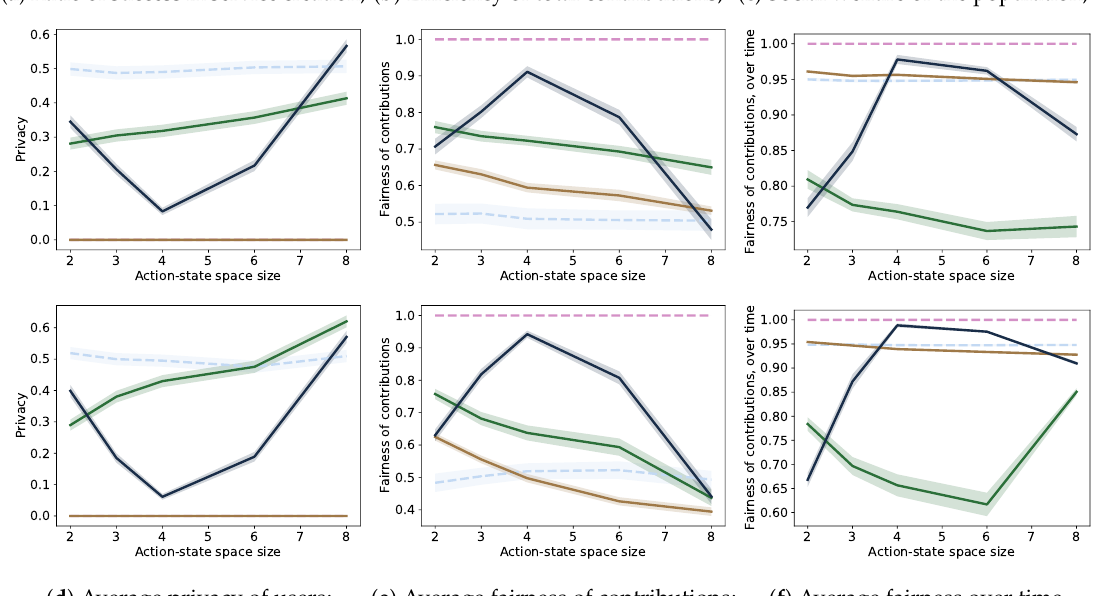
Figure A2. Dependence of results on the range of values and costs ( x -axis). Dashed lines represent baselines, solid lines represent contribution strategies. The plots show a trend for which all contribution strategies tend to perform worse for larger action-state spaces. Q-Learning is the measure that is most affected by the size of the action-state, in particular, it can be seen that its performance varies significantly on most measures for intermediate sizes. This result is driven by the fixed capacity of the neural network, which makes it more suitable for a certain degree of complexity in the input; the performance of a Q-Learning contribution strategy could be adapted to a given environment by changing the capacity of the network to a more suitable